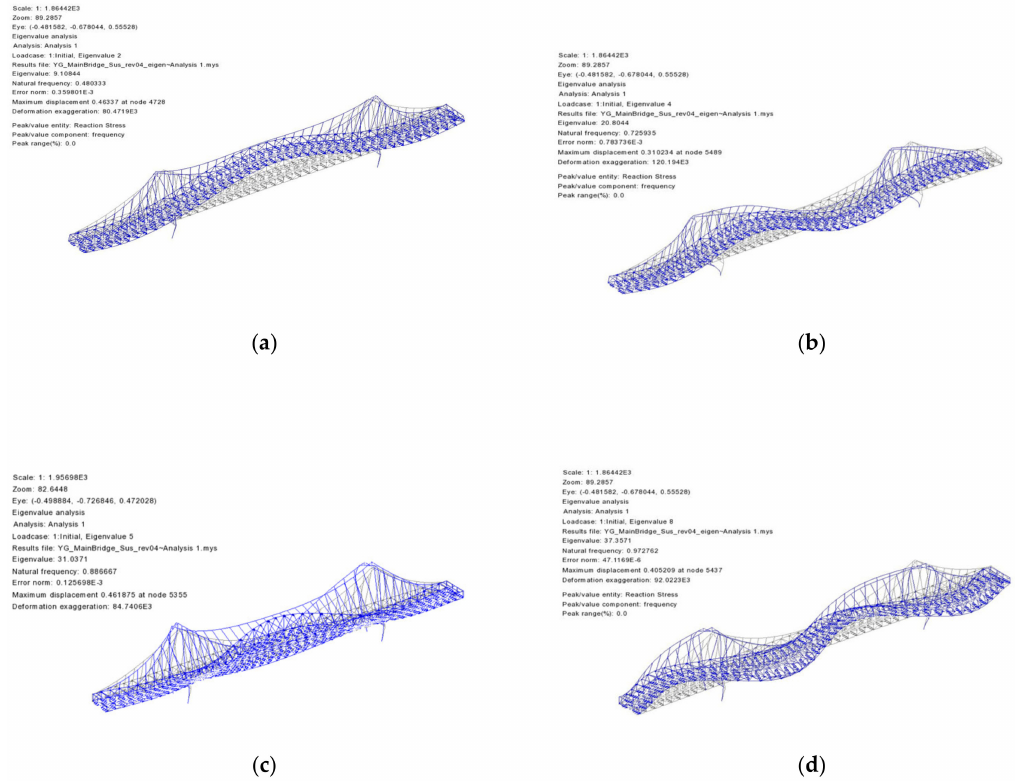
Figure 11. Yeongjong Bridge suspension bridge mode shapes. ( a ) 1st bending mode (0.480 Hz); ( b ) 2nd bending mode (0.725 Hz); ( c ) 1st torsional mode (0.887 Hz); ( d ) 2nd torsional mode (0.973 Hz).